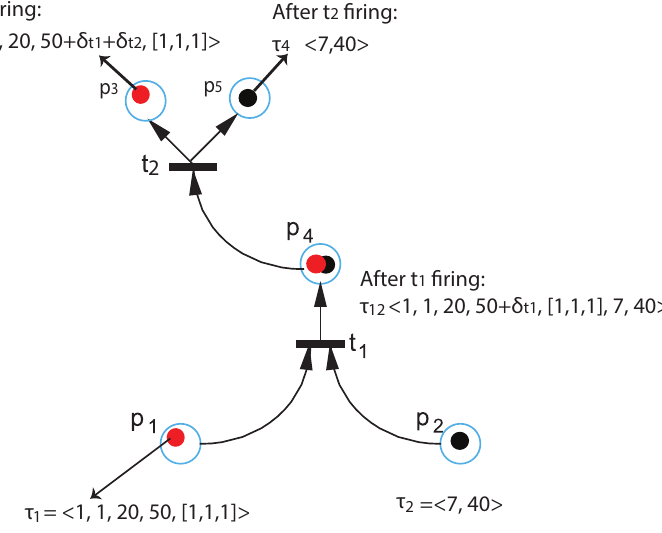
Figure 3. Example of an Enabled Transition in a Colored Petri Nets